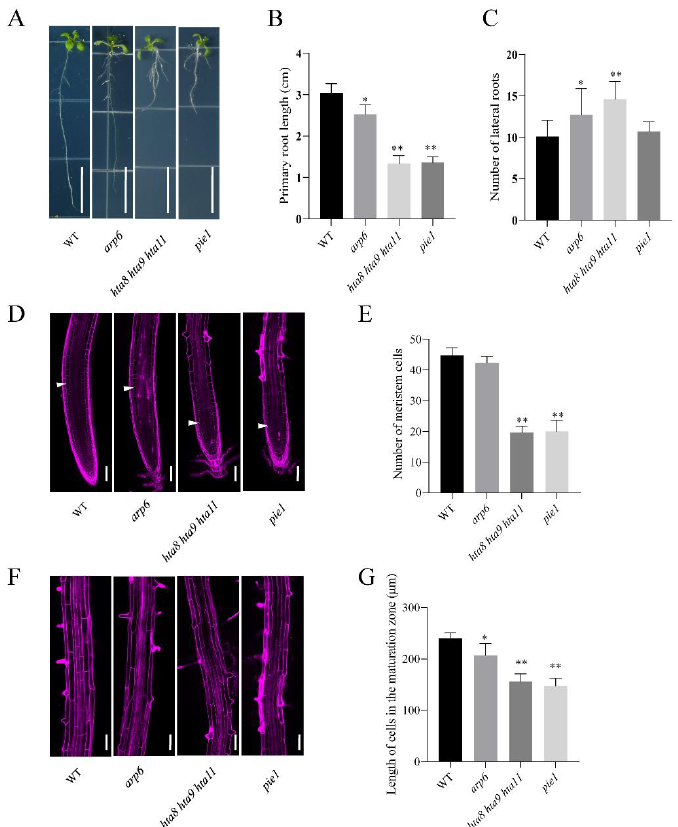
Figure 1. Arabidopsis H2A.Z deposition-deficient mutants show altered root length and lateral root formation: ( A ) Phenotypes of WT and H2A.Z deposition-deficient mutants arp6 , hta8 hta9 hta11 , and pie1 at 10 days after germination. Bar = 1 cm. ( B ) The primary root length of WT, arp6 , hta8 hta9 hta11 , and pie1 at 10 days after germination. Bars show standard deviations of at least 10 seedlings. Asterisks indicate significant differences between the WT and each mutant evaluated with Student’s t test (* p < 0.05, ** p < 0.01). Outlier values are represented by dots. ( C ) The lateral root number of WT, arp6 , hta8 hta9 hta11 , and pie1 at 10 days after germination. Bars show standard deviations of at least 10 seedlings. Asterisks indicate significant differences between the WT and each mutant evaluated with Student’s t test (* p < 0.05, ** p < 0.01). ( D ) Confocal images of root tips of WT, arp6 , hta8 hta9 hta11 , and pie1 with propidium iodide (Pi) staining. White arrows indicate the position above which is the first elongated cell. Bar = 100 µ m. ( E ) Number of meristem cells. The cortex cell number between the quiescent center and the first elongated cell was countered. At least 10 plants were evaluated per biological repeat. The error bars represent the standard errors of triplicate experiments. ** p < 0.01. ( F ) Confocal images of root maturation zone of WT, arp6 , hta8 hta9 hta11 , and pie1 with Pi staining. Bar = 100 µ m. ( G ). Length of cells in the maturation zone. At least 10 plants were evaluated per biological repeat. The error bars represent the standard errors of triplicate experiments. * p <0.05, ** p <